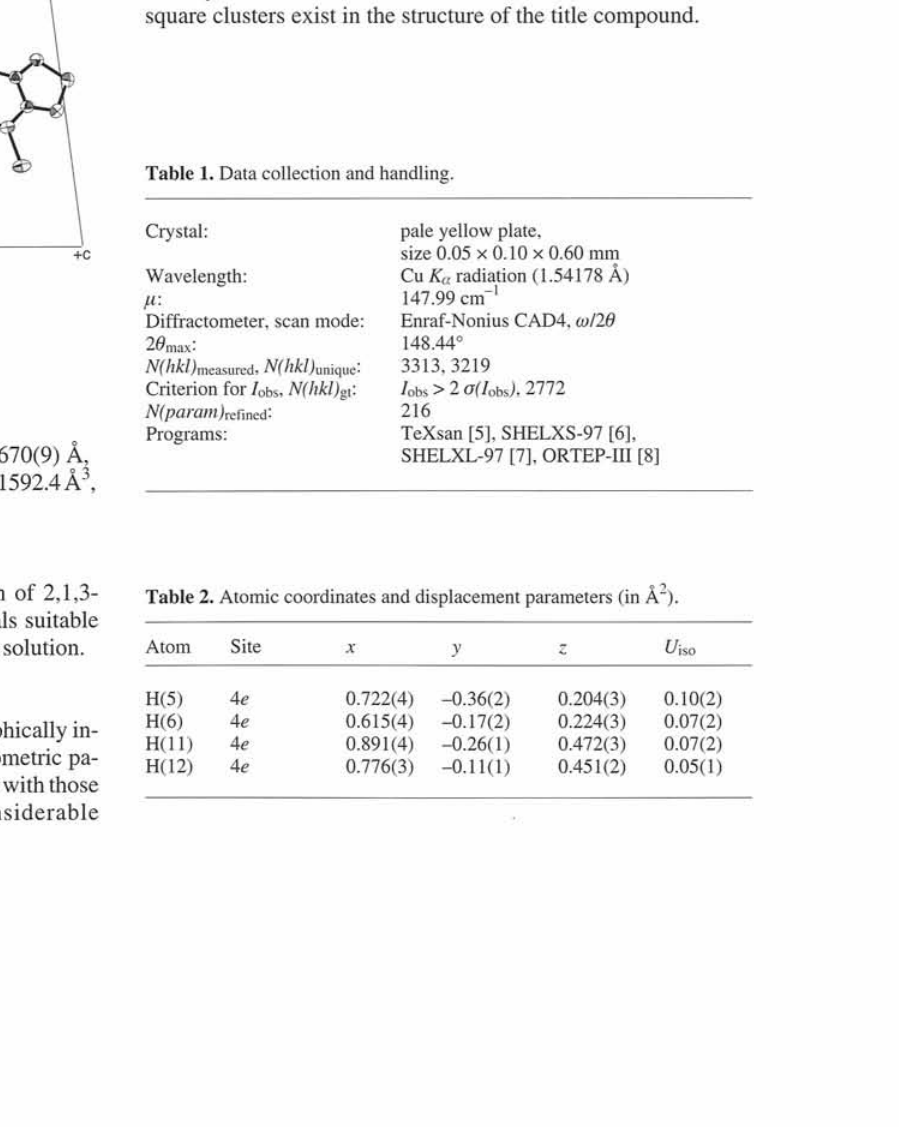
Table 1. Data collection and handling.